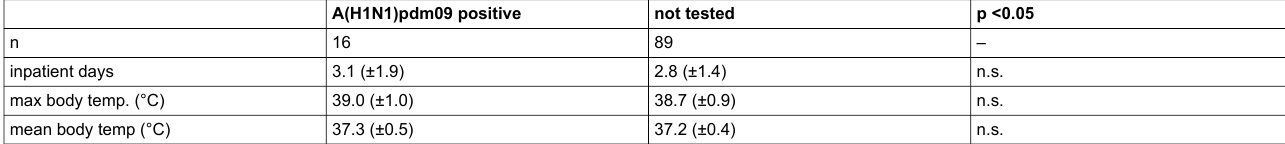
Table 3: Comparison of the subpopulation tested for A(H1N1)pdm09 in comparison to the remaining patients. Data sets are presented as mean (± SD). Student’s t-Test for unpaired samples has been used to compare the two groups. p <0.05 was considered